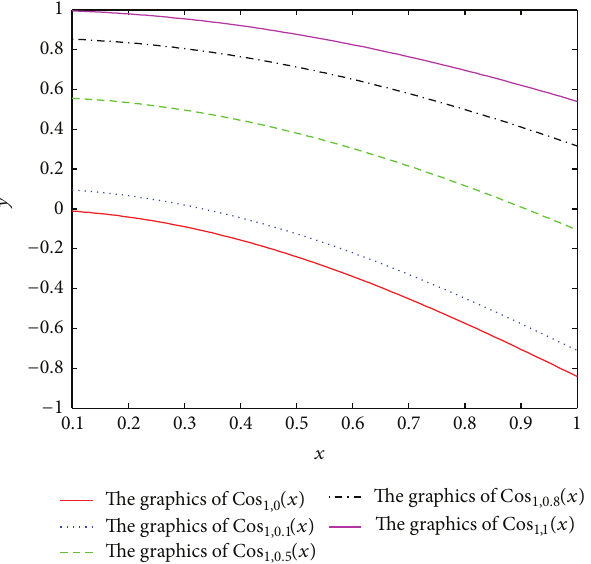
Table 7: Exact solution, approximate solution, and accuracy